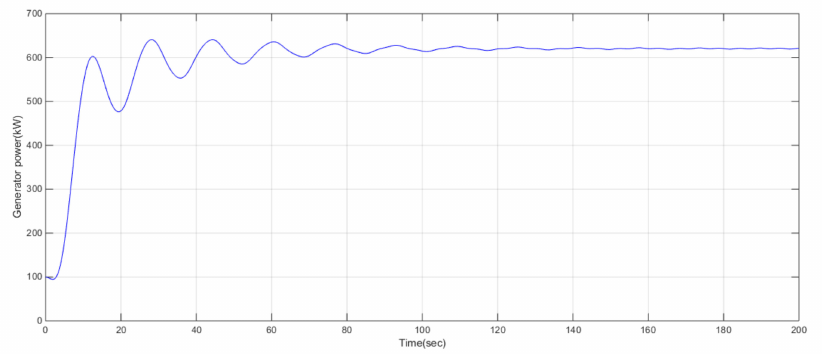
Figure 3. P g predicted without